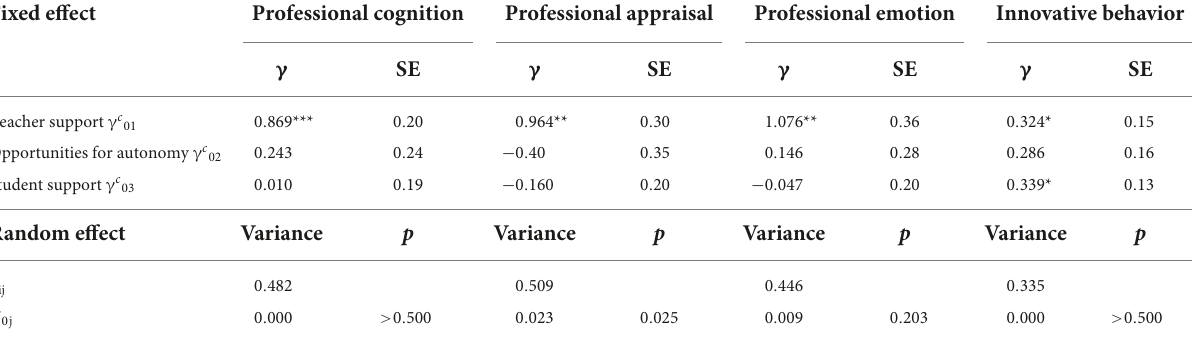
TABLE 3 Summary of hierarchical linear modeling analysis of learning environment with professional identity and innovative